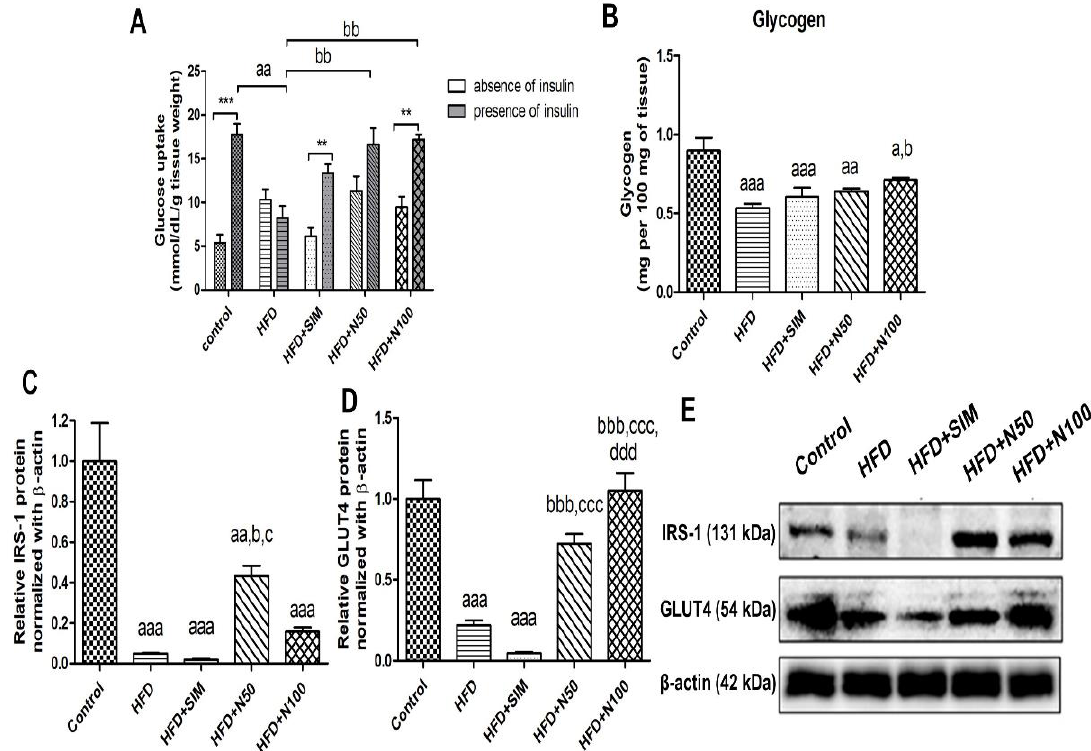
Figure 2. The effect of naringin on glucose uptake, glycogen content, and protein expressions in the quadriceps of the high-fat diet fed rats. Glucose uptake presence or absence insulin ( A ) and the glycogen content ( B ) in the quadriceps muscle tissues of the rats. ( E ) Representative protein expression images of IRS-1 ( C ) and GLUT4 ( D ) in the quadriceps tissues. Results are shown as mean ± SEM for 5 to 6 rats per group. **, *** p < 0.01 and 0.001 when compared to the absence of insulin. a p < 0.05, aa p < 0.01, and aaa p < 0.001 vs. the control group; b p < 0.05, bb p < 0.01, and bbb p < 0.001 vs. the HFD group; c p < 0.05, and ccc p < 0.001 vs. the HFD + SIM group; ddd p < 0.001 vs. the HFD group.